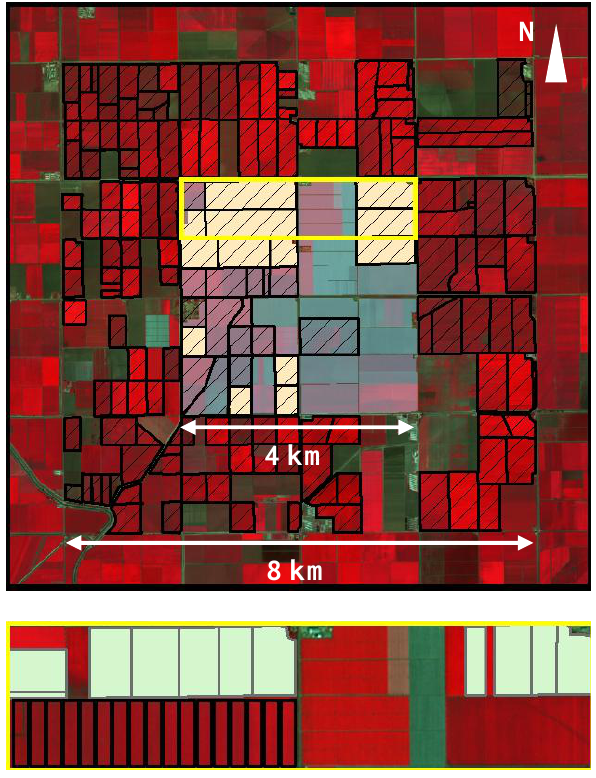
Fig. 1. The 8 × 8km 2 study area delineated on a Formosat-2 image, with its 4 × 4km 2 central part highlighted. Wheat fields are hatched Figure 1. The 8×8 km² study area delineated on a Formosat-2 image, with its 4×4 km² central part in black. Agricultural practices were collected on 12 wheat fields (beige fields). The bottom zoomed yellow area shows the largest highlighted. Wheat fields are hatched in black. Agricultural practices were collected on 12 wheat fields where grain yield (green subfields) and irrigation (black seg- ments) were fields (beige fields). The bottom zoomed yellow area shows the largest fields where grain yield (green subfields) and irrigation (black segments) were collected.